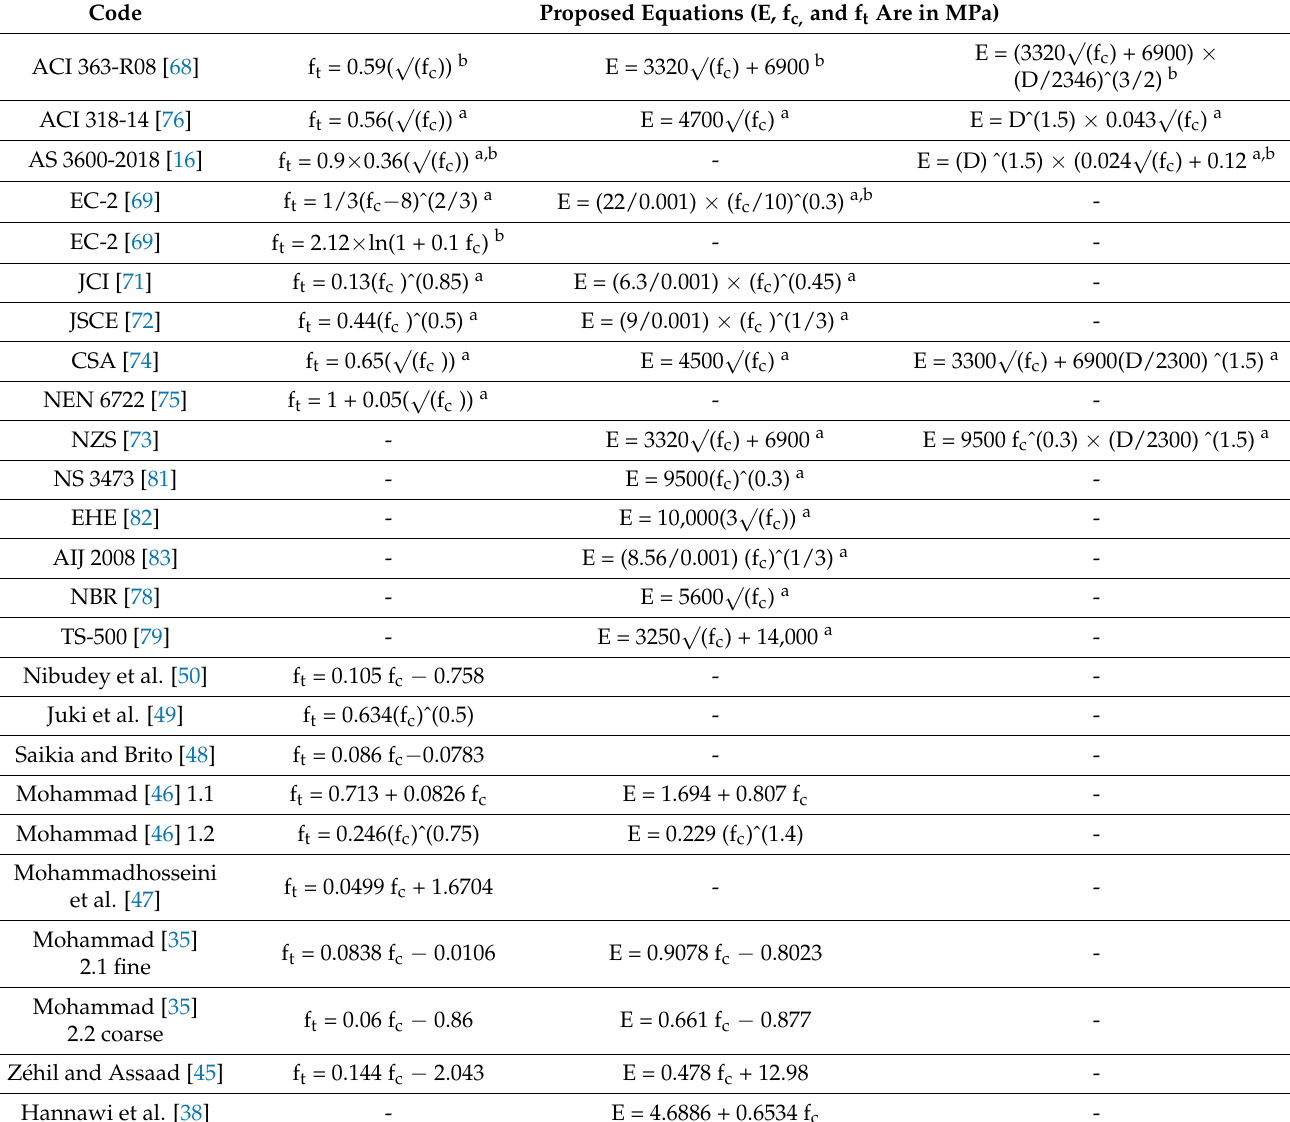
Table 3. Proposed models introduced by international codes and other researchers regarding the tensile strength and modulus of elasticity prediction of BPW-containing